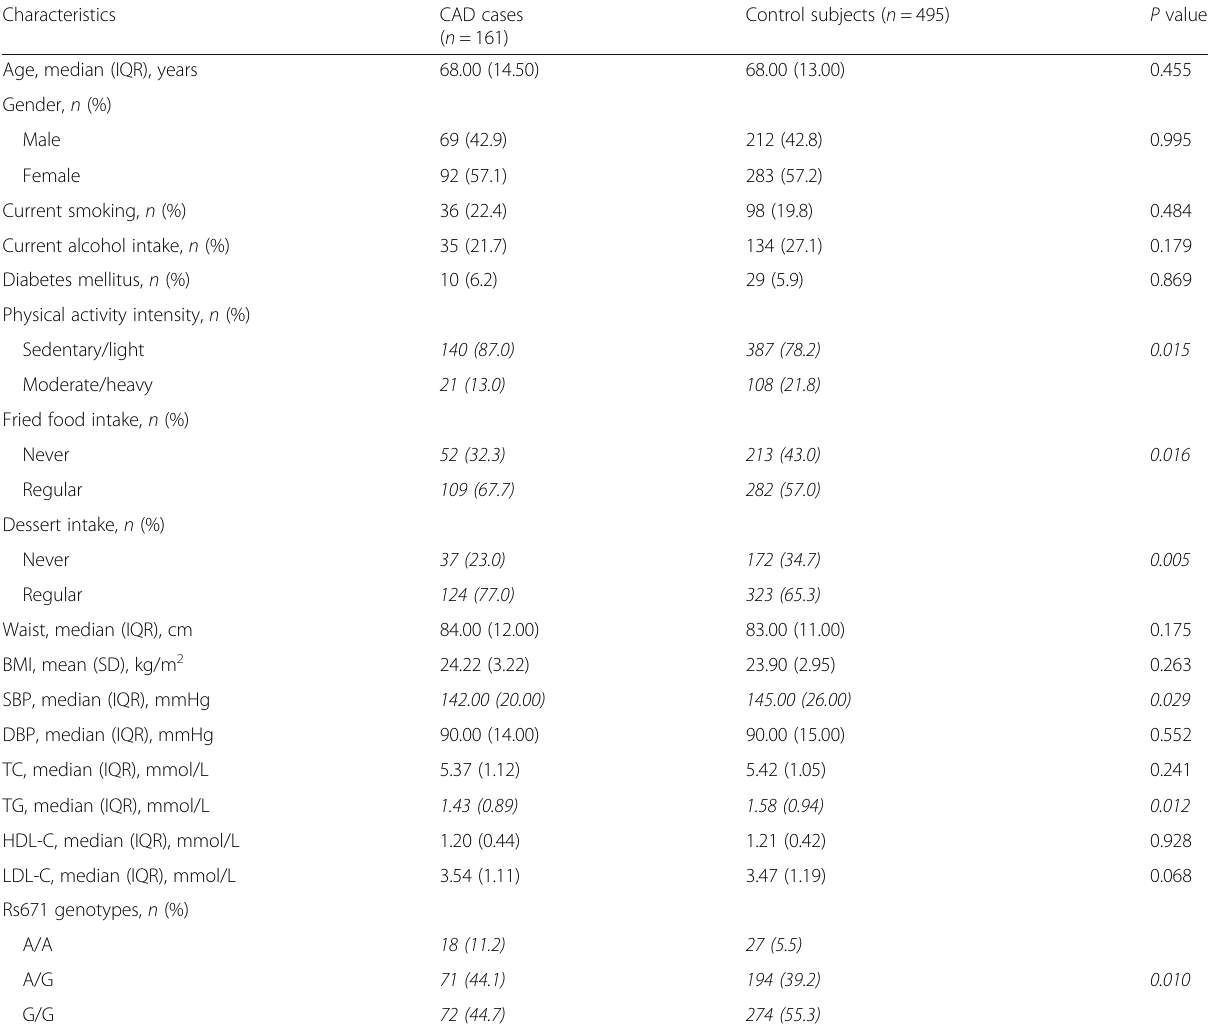
Table 1 General characteristics of the participants recruited in the CAD cases and controls